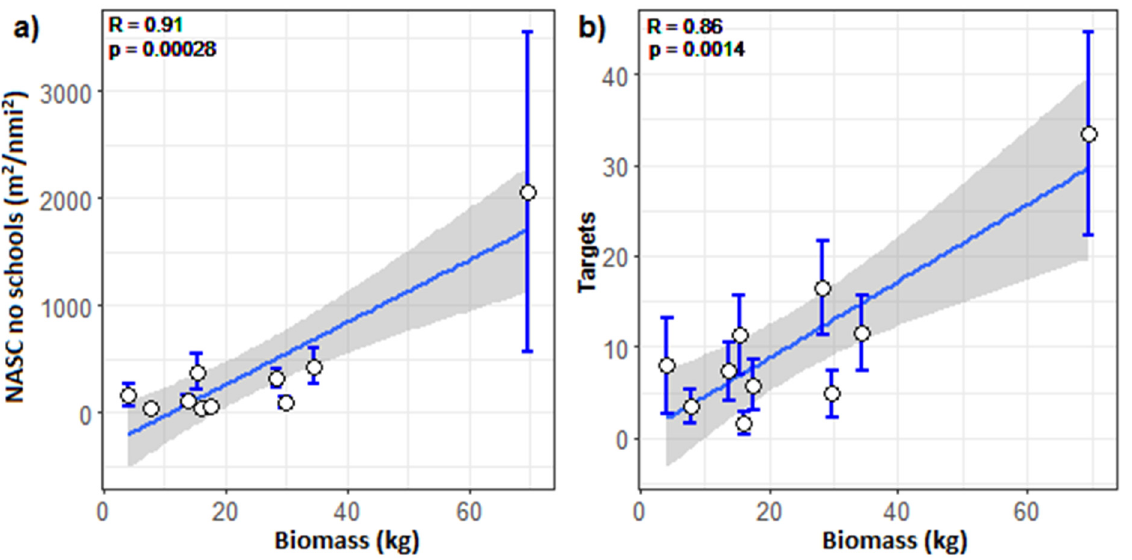
Figure 4. Correlations between ( a ) the relative biomass from stereo-BRUVs (kg) and the acoustic NASC BRUV-mean no schools using a radius of 300 m around the stereo-BRUVs and summing three layers (0.5 to 15.5 m) above the seafloor, ( b ) acoustic targets and relative biomass (kg) from the stereo-BRUVs with 300 m radius of search including only two layers (0.5–10.5 m) above the seafloor. The standard errors are shown as error bars. A linear regression with 95% confidence intervals is shown as a blue line with a grey band.